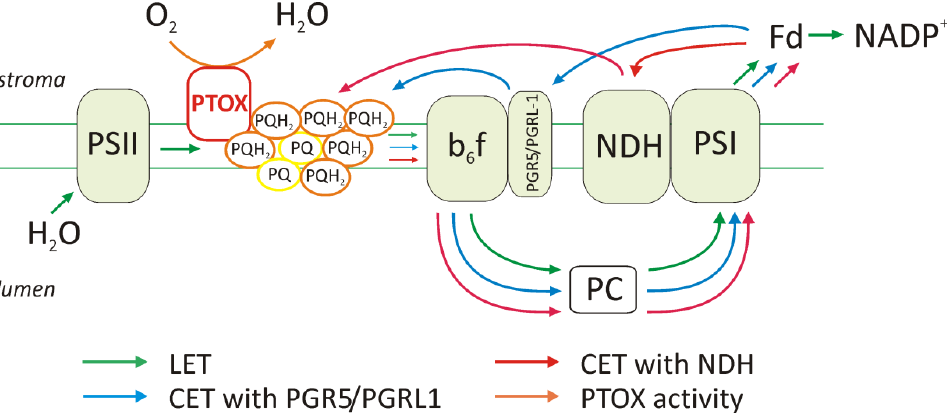
Figure 3. The ways of electron transport in the thylakoid membrane under high light intensities and over-reduction of the plastoquinone pool (PQ). The scheme shows linear electron transport (LET), cyclic electron transport (CET), which takes place with the participation of the proteins PGR5 and PGRL1 or/and the NDH complex, and the activity of PTOX in the chlororespiration process. The content of complexes and the activity of the electron transport pathway will differ in the M and BS chloroplasts in particular metabolic subtypes and depending on environmental conditions.